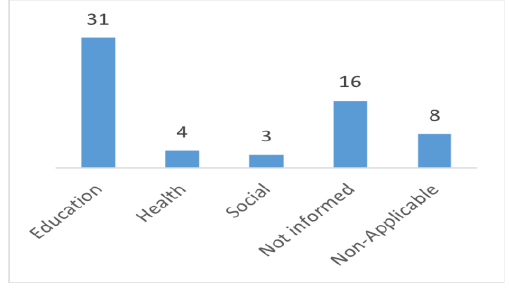
Figure 5. Paper’s Context.